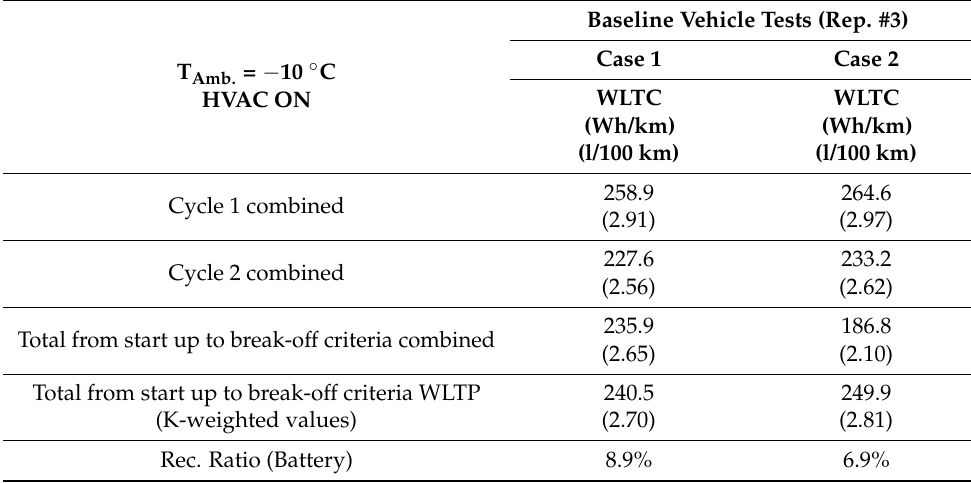
Table 5. Energy consumption results (Wh/km) for the WLTP CCT at − 10 ◦ C (HVAC on) for the baseline vehicle [14]. Results for the two measurement cases (Case 1—CAN current and CAN voltage measurements; Case 2—AC/DC clamp for current and CAN voltage